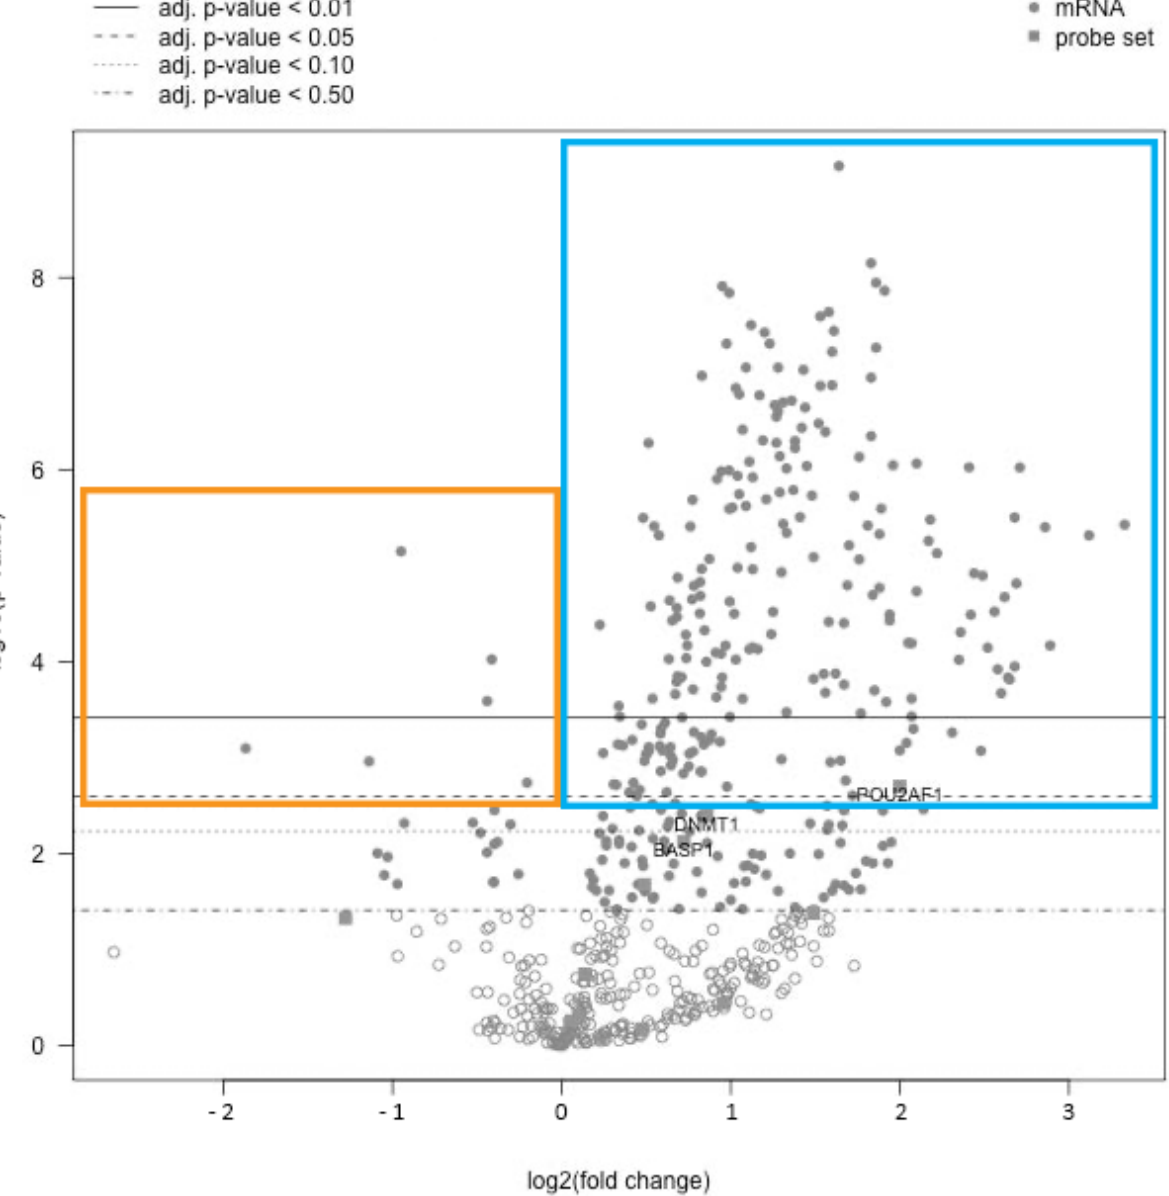
Figure 4. Gene expression profile. Volcano plot representing the gene expression profile of c-ABMR compared with the control group. The x -axis represents the fold change (log2) and the y -axis the gene’s p -value ( − log10). Horizontal lines indicate adjusted p -value threshold. For our study, we considered statistically relevant the genes with a p -value < 0.05 (dashed line, second from top) or <0.01 (continuous line, first from top). Two hundred and twenty-one genes presented a statistically significant positive fold change and were therefore more expressed in the c-ABMR group (blue box), 170 of them with a p -value < 0.01 and 51 with a p -value < 0.05. Six genes presenting a statistically significant negative fold change were related to the control group (orange box).